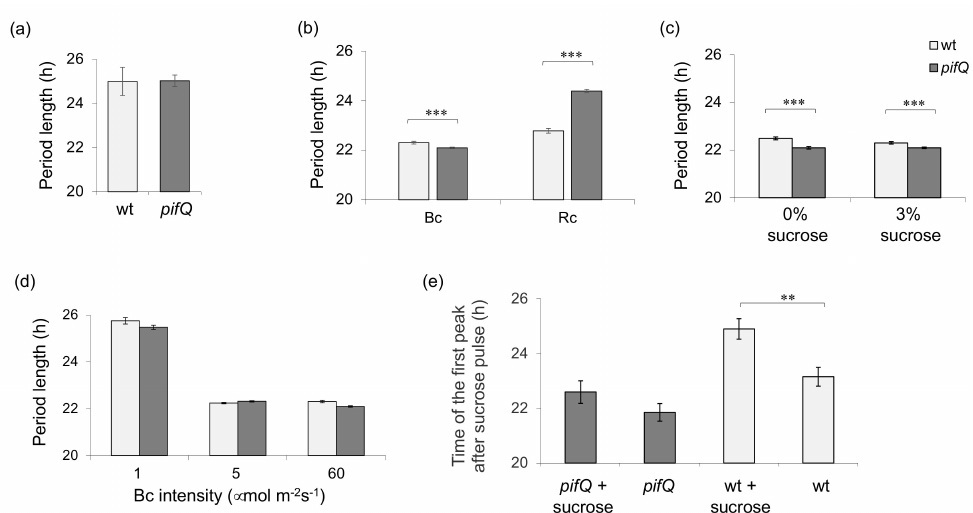
Figure 1. Blue and red light have different effects on PIF-mediated sucrose signaling. ( a ) The circadian period of leaf movements of wt and pifQ mutants grow on 2% sucrose containing medium for 8 days in 14 h: 10 h, light: dark (white light, 100 µ mol m − 2 s − 1 ) before being transferred to constant blue light (Bc) of 60 µ mol m − 2 s − 1 . Average of 2 biological repeats, n ≥ 13. ( b – d ) Luciferase activity of pifQ CCA1:LUC and wt CCA1:LUC plants grown for 8 days in 14 h: 10 h, light: dark (white light, 100 µ mol m − 2 s − 1 ) on medium ( b , d ) with or ( c ) with and without 3% sucrose and transferred to either ( b ) Constant blue light (Bc) (60 µ mol m − 2 s − 1 ) and constant red light (Rc) (50 µ mol m − 2 s − 1 ) or ( c ) Bc (60 µ mol m − 2 s − 1 ) or ( d ) Bc of different light intensities (1, 5, 60 µ mol m − 2 s − 1 ). ( e ) Sucrose pulse experiments were performed as described in Materials and Methods. ** p < 0.01 *** p < 0.001 (Student two-tailed t -test). Average of ( a ) 2 biological repeats. n ≥ 106, ( b – d ) 2–3 biological repeats. n ≥ 112 ( e ) 3 biological repeats n ≥ 36.